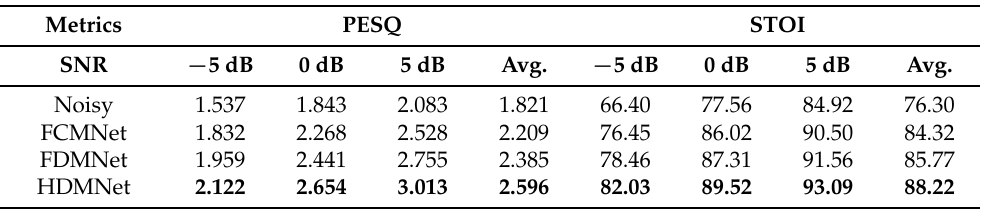
Table 3. Experimental results of different modules under seen noise conditions for PESQ and STOI. BOLD indicates the best result for each